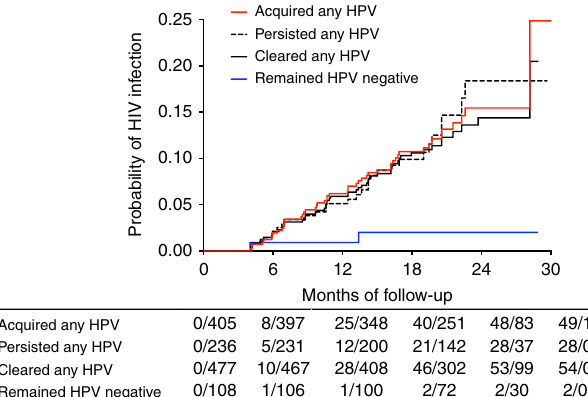
Fig. 3 Kaplan – Meier curves representing the relationship between HPV infection and HIV risk. Associations of HIV incidence were determined by modeling time to HIV infection with multivariable Cox proportional hazards regression models, where time spent in the study was calculated from randomization to the estimated date of HIV infection or the date